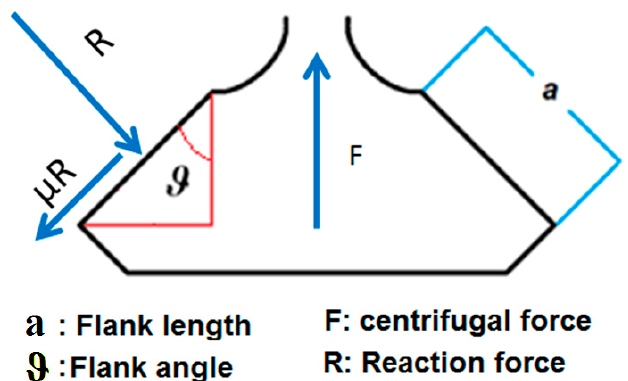
Figure 2. The flank length and flank angle, the design variables in this study.